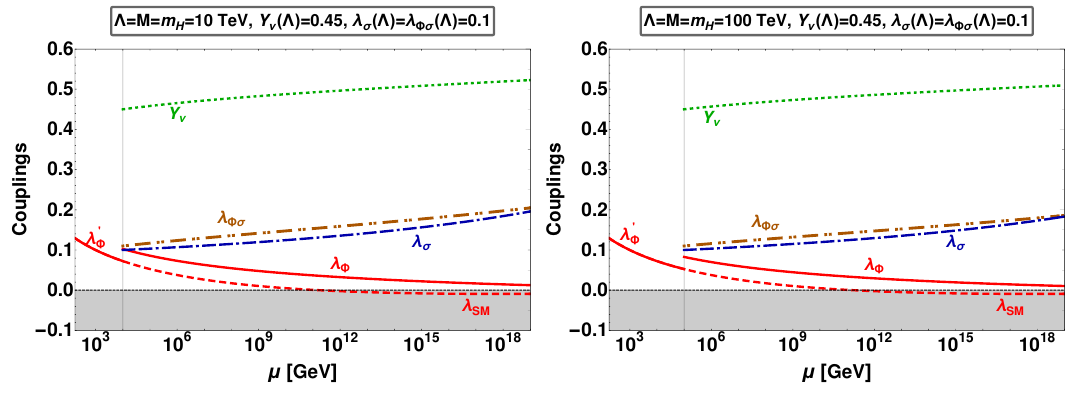
Figure 8 . The RG evolution of the quartic couplings and right-handed neutrino Yukawa couplings within the Majoron extension of (3,1,1) inverse seesaw scheme. For comparison, we also show the evolution of λ SM (red-dashed). Here λ 0 ≡ λ κ is the effective Higgs quartic coupling below threshold, Φ see eq.